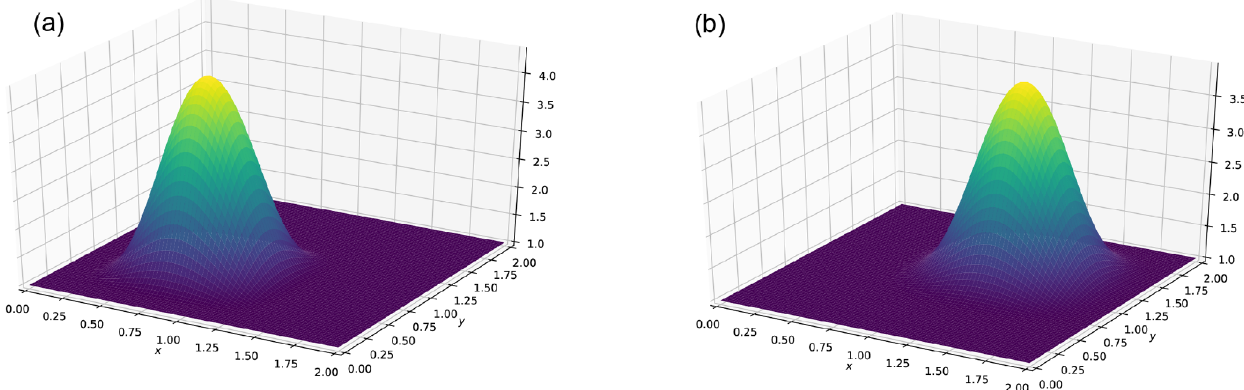
Figure 15. Initial (a) and final (b) time of the simulation of the convection equation.